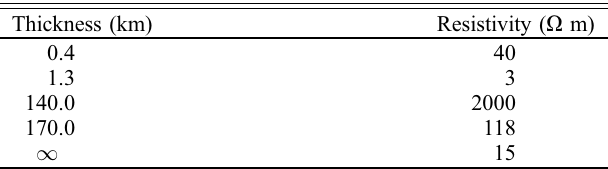
Table 1. Thicknesses and resistivities of the layers in the ground model applied for whole Europe in a test